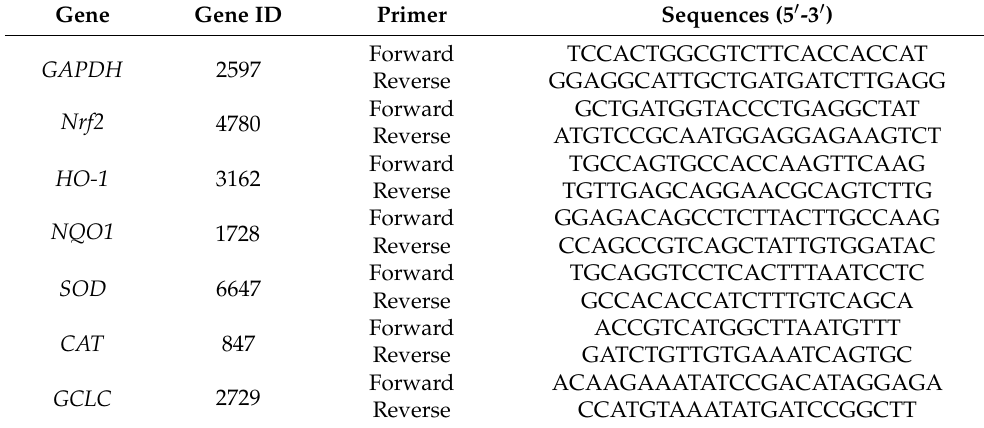
Table 1. Primer sequences.